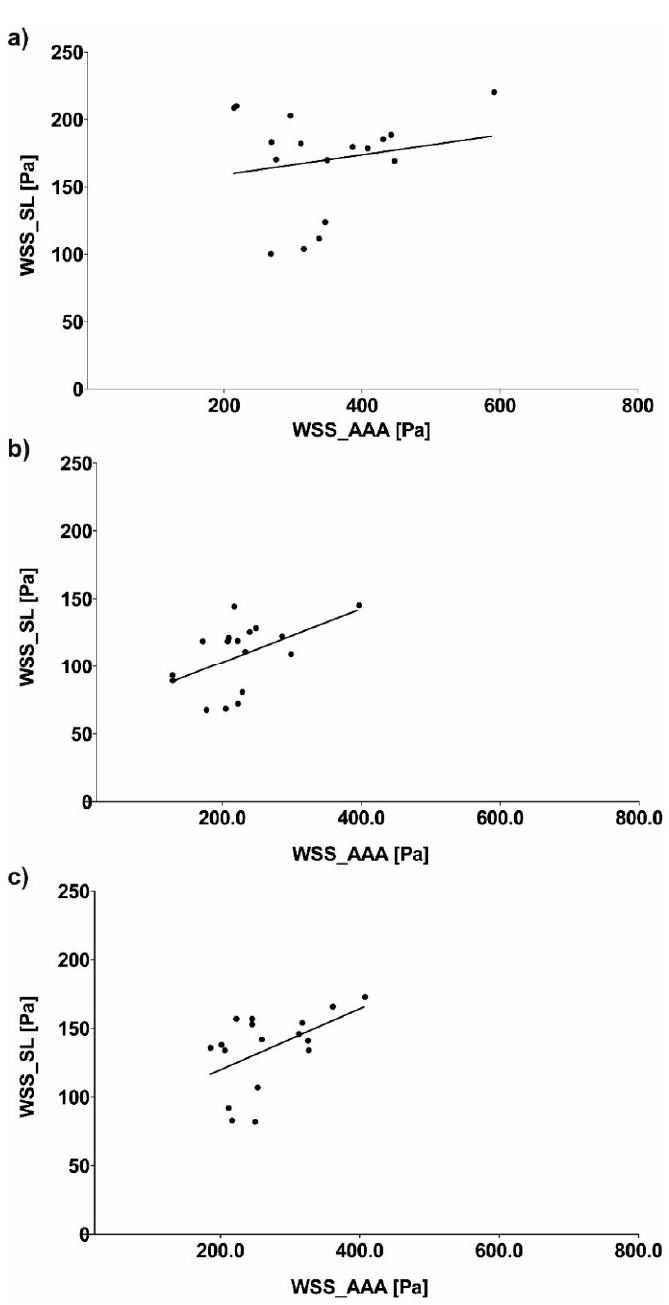
Figure 8. Scatterplot graphic representation of Pearson’s correlation factors rho [-] for the analyzed WSS_SL in function of WSS_AAA for: ( a ) Sharp profile (rho = 0.1889, p = 0.467), ( b ) flat profile (rho = 0.5052, p = 0.038), ( c ) real profile (rho = 0.5050, p = 0.038).